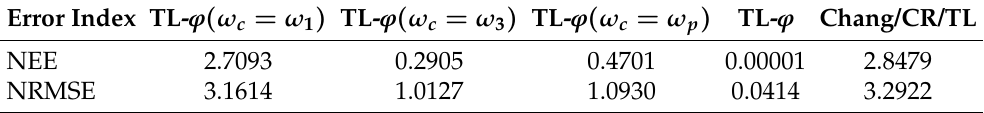
Table 8. Displacement errors for m 50 ( ˜ ω = 16 rad/s, %).